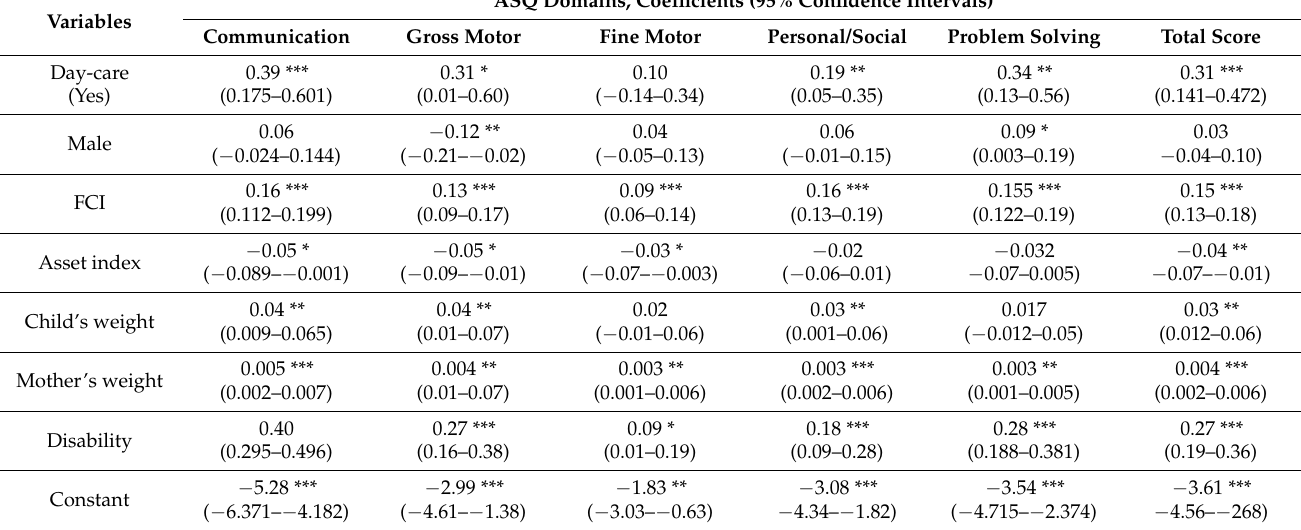
Table 3. Coefficient estimates from multivariable linear regression models, regressing round two ASQ z-scores on individual and household characteristics.